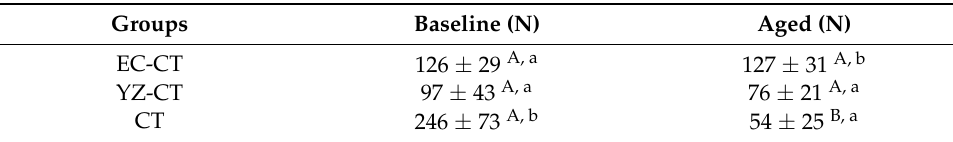
Table 6. Retention force mean values and standard deviations. Statistically significant differences between groups determined with Fisher-LSD post-hoc test indicated with varying superscript letters ( p > 0.05) (upper case horizontal, lower case vertical).